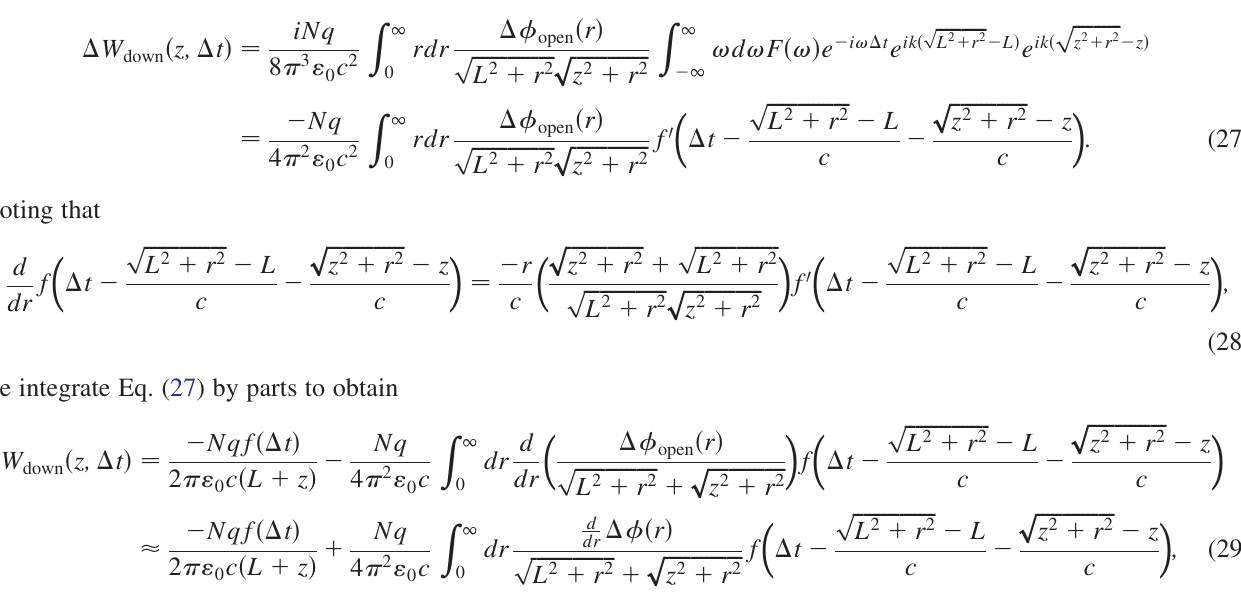
ffiffiffiffiffiffiffiffiffiffi p z 2 þ r 2 ffiffiffiffiffiffiffiffiffiffiffiffiffiffiffi